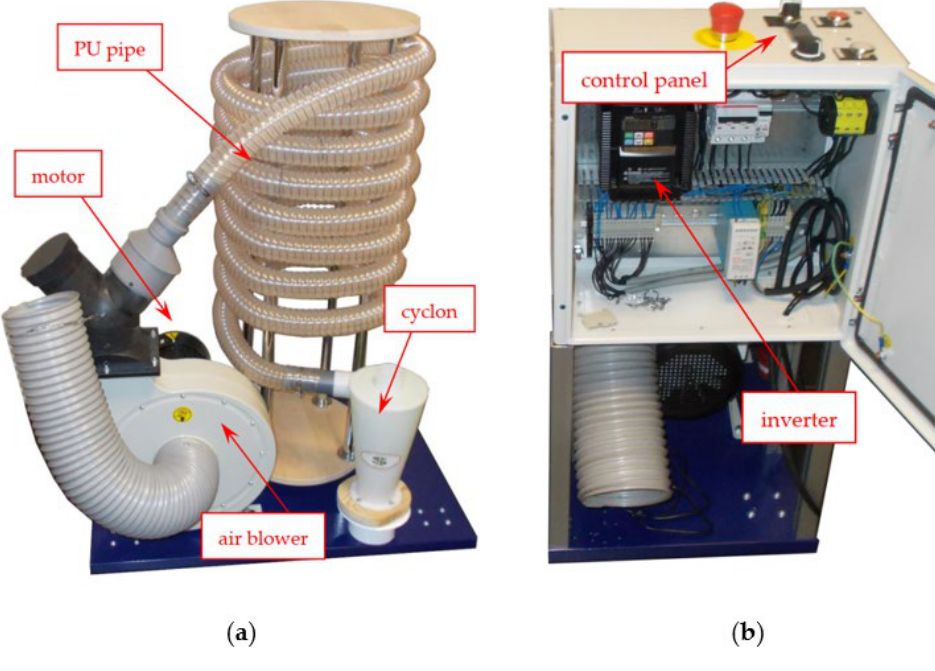
Figure 3. Tribocharger setup ( a ) and control cabinet ( b ).